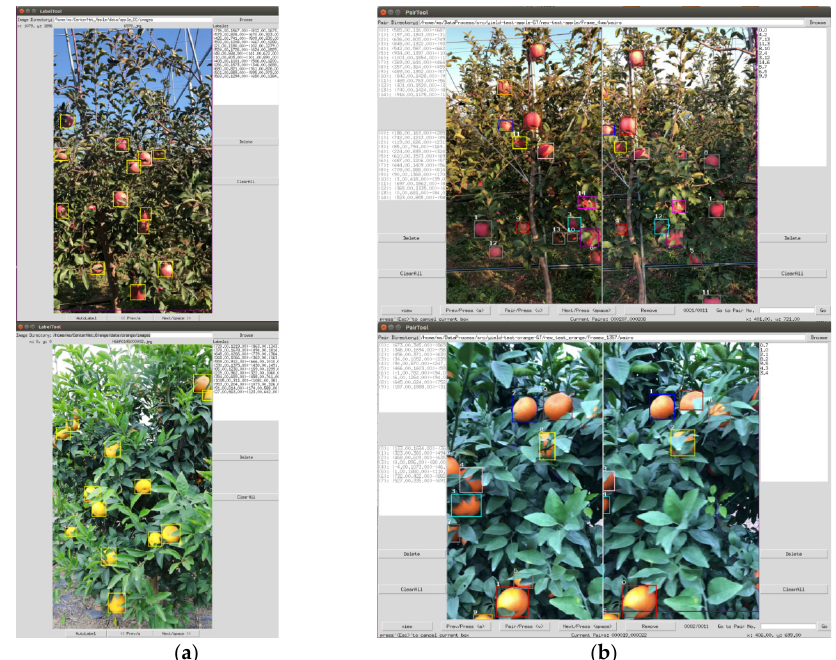
Figure 2. Self-developed tools for data annotation. ( a ) Coordinates label tool, ( b ) Pair tool.